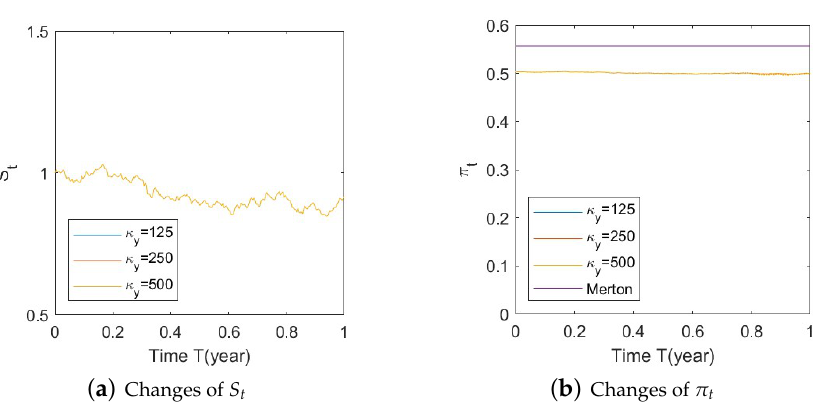
Figure A34. Illustrate the impact on ( a ) stock prices and ( b ) optimal stock allocations when varying the speed of reversion, κ y ( e . g ., κ y = 125,250,500 ) .